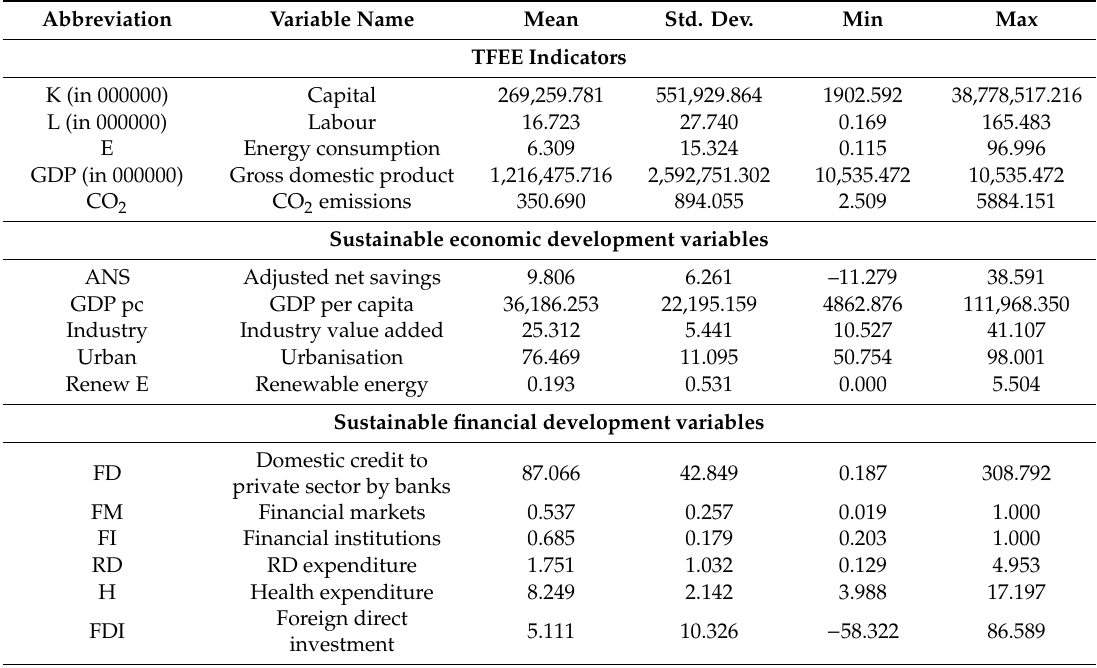
Table 3. Descriptive statistics of data.